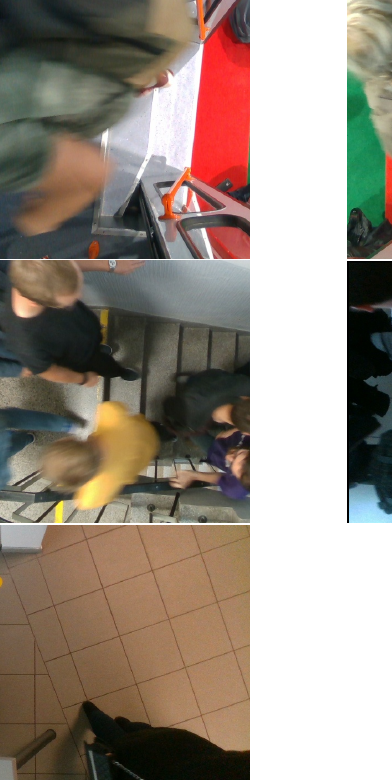
Figure 3. Some examples taken from the first dataset.